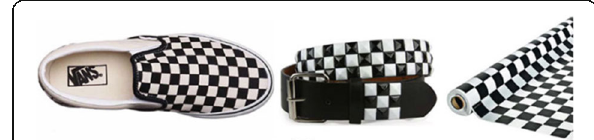
Fig. 2 Surfaces with similar textures may be composed of different materials. These objects are made of fabric, plastic, and paper, from left to right